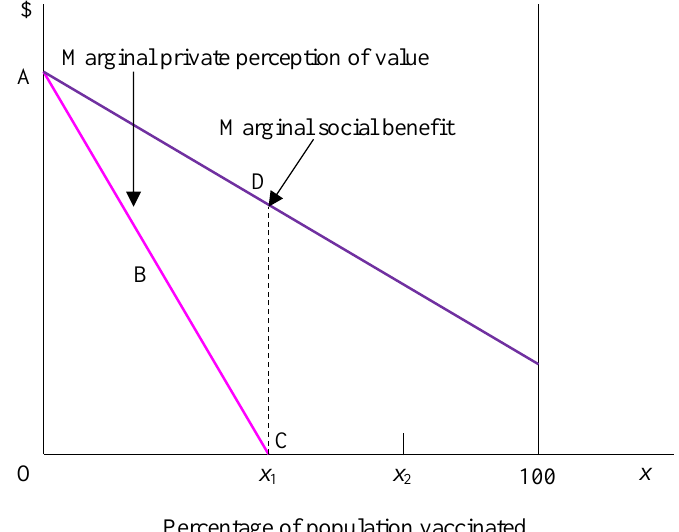
Figure 1. Illustration that the marginal private perception of the value of vaccination to control a pandemic can be a lot less than the marginal social benefit of vaccination. This can support government measures to counteract this problem.